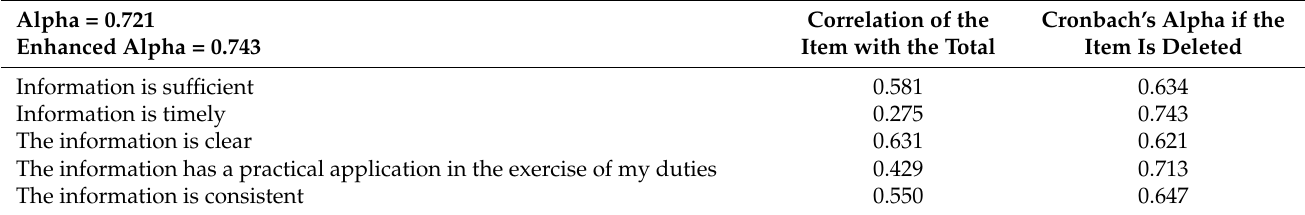
Table 6. Reliability of the “Interdepartmental communication” dimension.